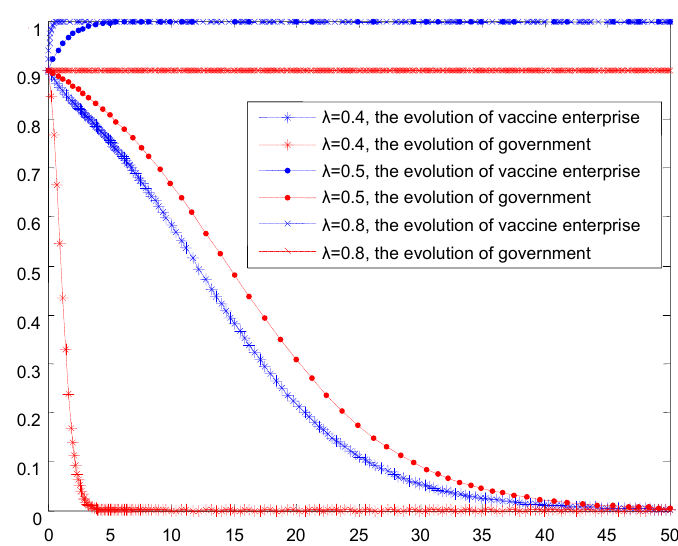
Figure 6. Simulation results of the evolutionary game between the two parties under the condition that the probability of third-party reporting is improved.